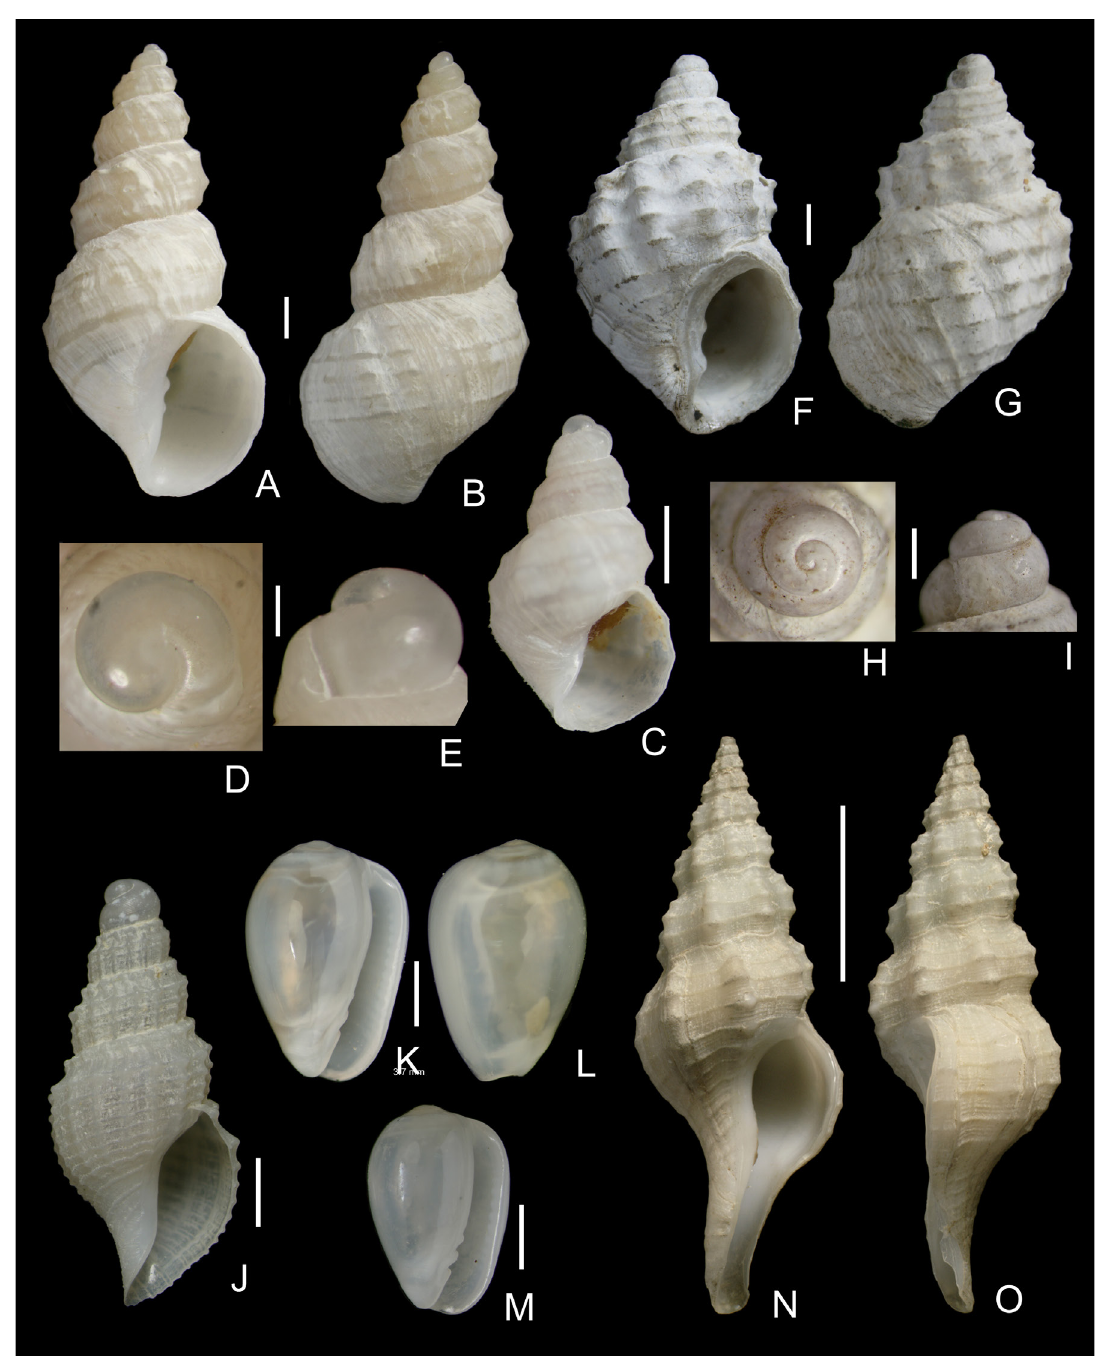
Fig. 25. Cancellariidae, Belomitridae, Cystiscidae, Fasciolariidae. A–B . Brocchinia cf. clenchi Petit, 1986, BANGAL 0711, V9, 1671 m, live collected specimen, 10.8 mm. C . Brocchinia cf. clenchi , juvenile specimen, BANGAL 0711, V2, 1706 m, 4.1 mm. D–E . Same specimen, detail of the protoconch. F–G . Brocchinia azorica (Bouchet & Warén, 1985), BANGAL 0711, V5, 1631 m, 9.3 mm. H–I . Detail of the protoconch of another shell, BANGAL 0711, V2. J . Belomitra quadruplex (Watson, 1882), BANGAL 0711, V10, 1720 m, 6.2 mm. K–M . Gibberula abyssicola Locard, 1897, SEAMOUNT 1, DW116, 985–1000 m, 3.7 and 3.2 mm. N–O . Fusinus bocagei (P. Fischer, 1882), ECOMARG 0709, V4, 735 m, 33 mm. Scale bars:A–C, F–G, J–M = 1 mm; D–E, H–I = 200 µm; N–O = 10